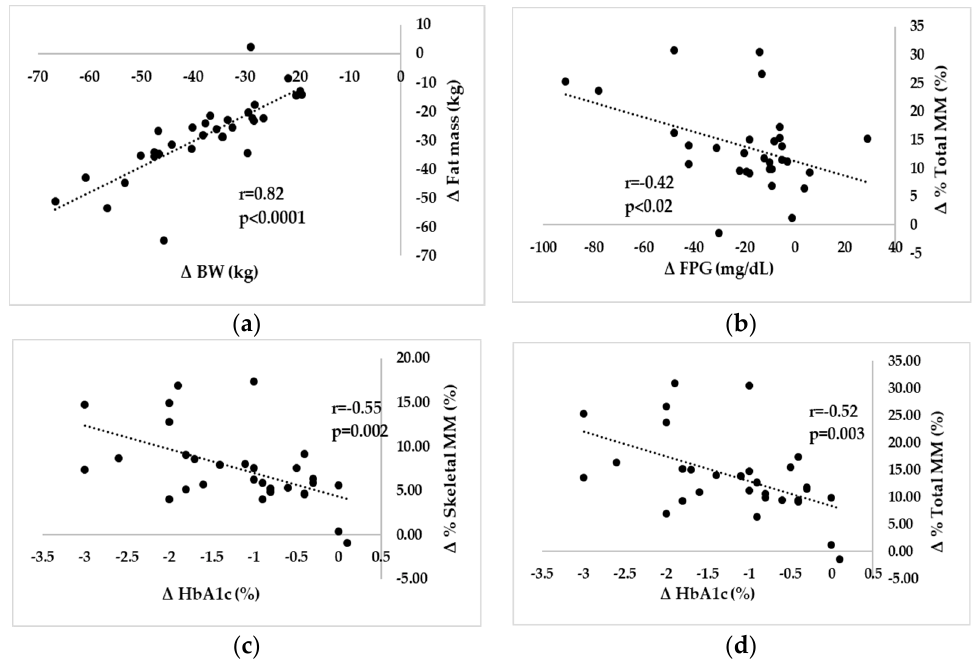
Figure 1. Correlation between changes in body compositions and changes in glycemic metabolic parameters. ( a ) relationship between BW and fat mass; ( b ) relationship between FPG and % total MM; ( c ) relationship between HbA1c and % skeletal MM; ( d ) relationship between HbA1c and % total MM, Variables: ∆ (0–12 month) variables; BW: body weight, MM: muscle mass, FPG: fasting plasma glucose,